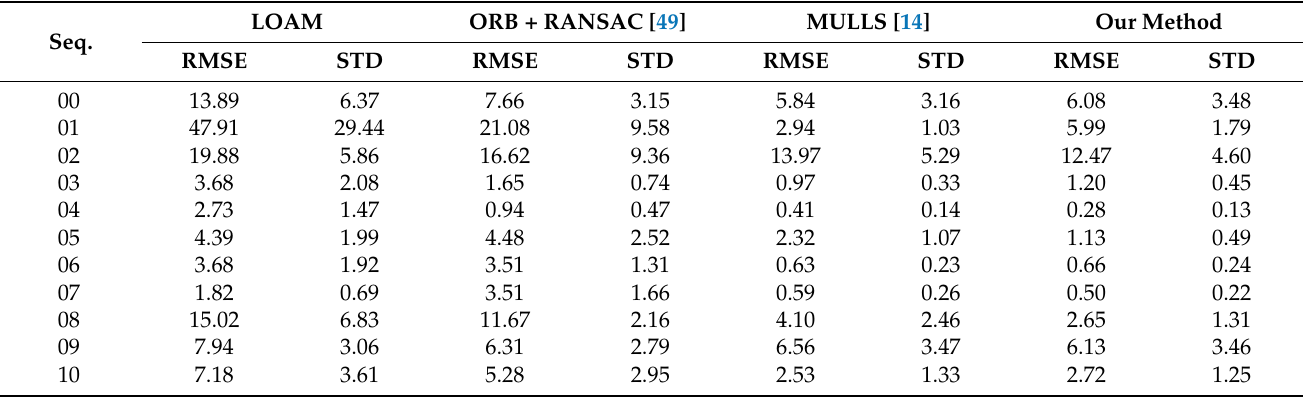
Table 1. Absolute trajectory error of our LiDAR odometry against LOAM and method in [49]. The unit of RMSE and STD is “meters”. The MULLS algorithm is performed by setting different configuration files provided by the author for sequence 01 to obtain the best